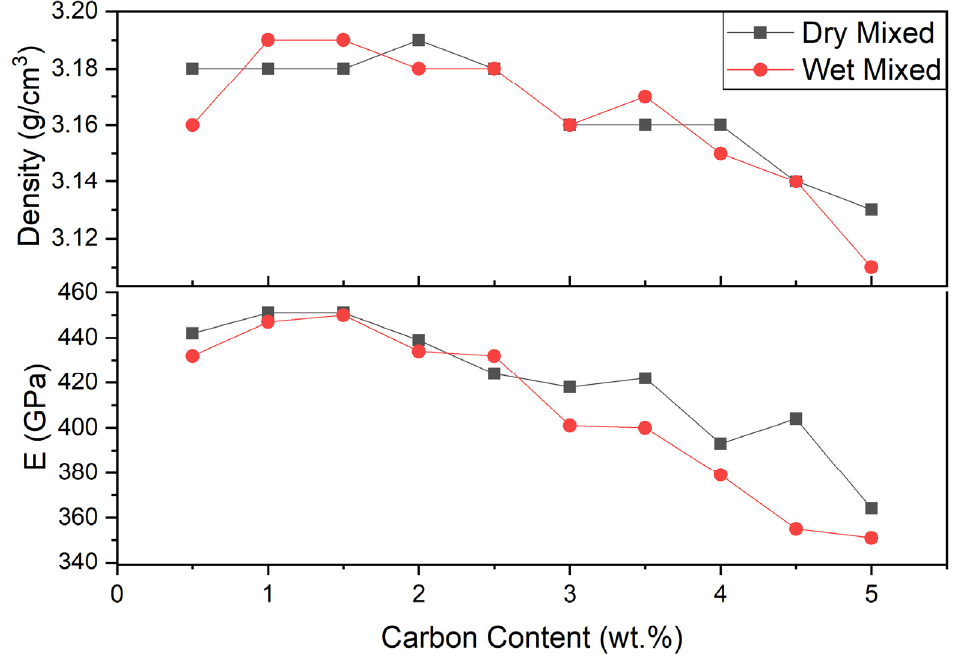
Figure 2. Dry–wet mixed SiC samples density and elastic modulus vs. carbon content.